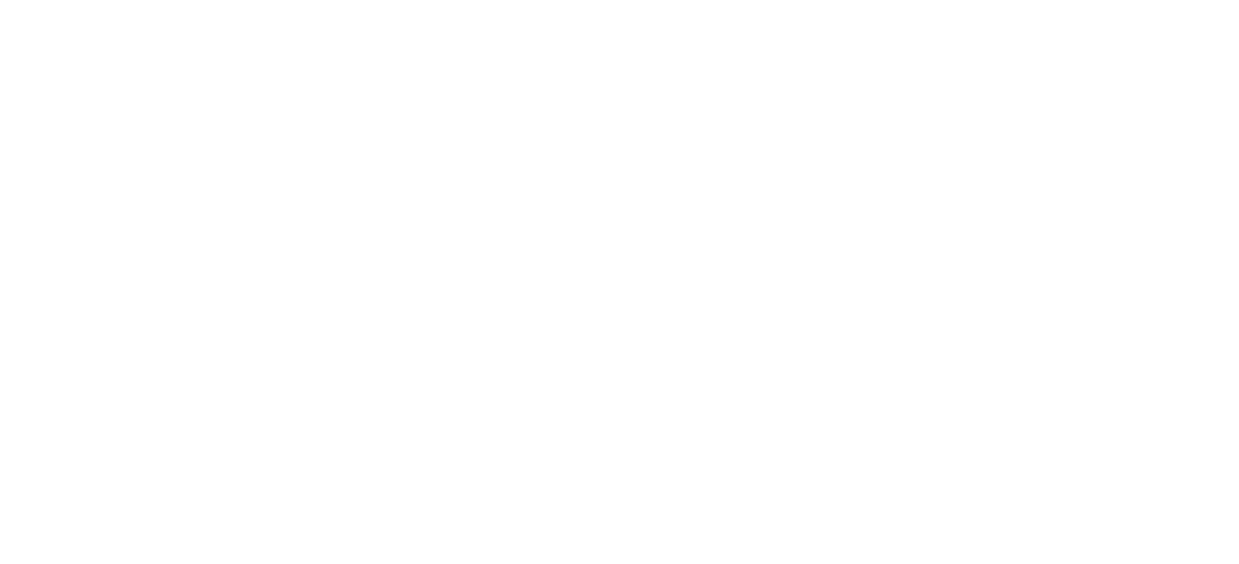
FIGURE A1 | The aster plot, bubble chart, and their explanations in the ExamVis score